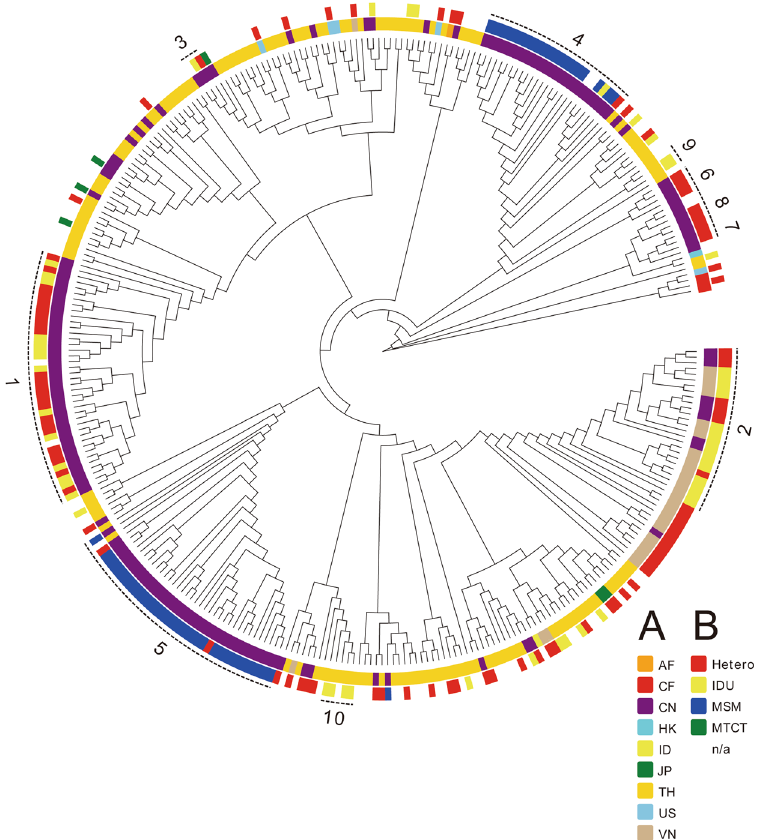
Figure 1. Maximum-likelihood phylogeny of HIV-1 CRF01_AE strains. Maximum-likelihood phylogeny of near-complete genome sequences of HIV-1 CRF01_AE. The two circles of colored cells show geographic location (inner circle, A ) and risk group (outer circle, B